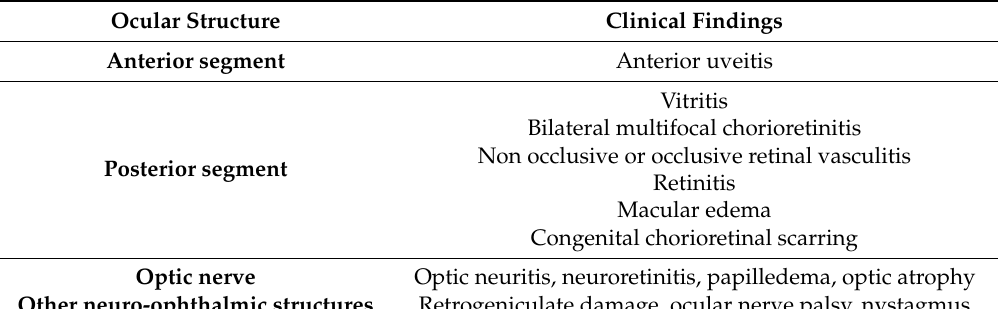
Table 1. Ophthalmic manifestations of West Nile virus